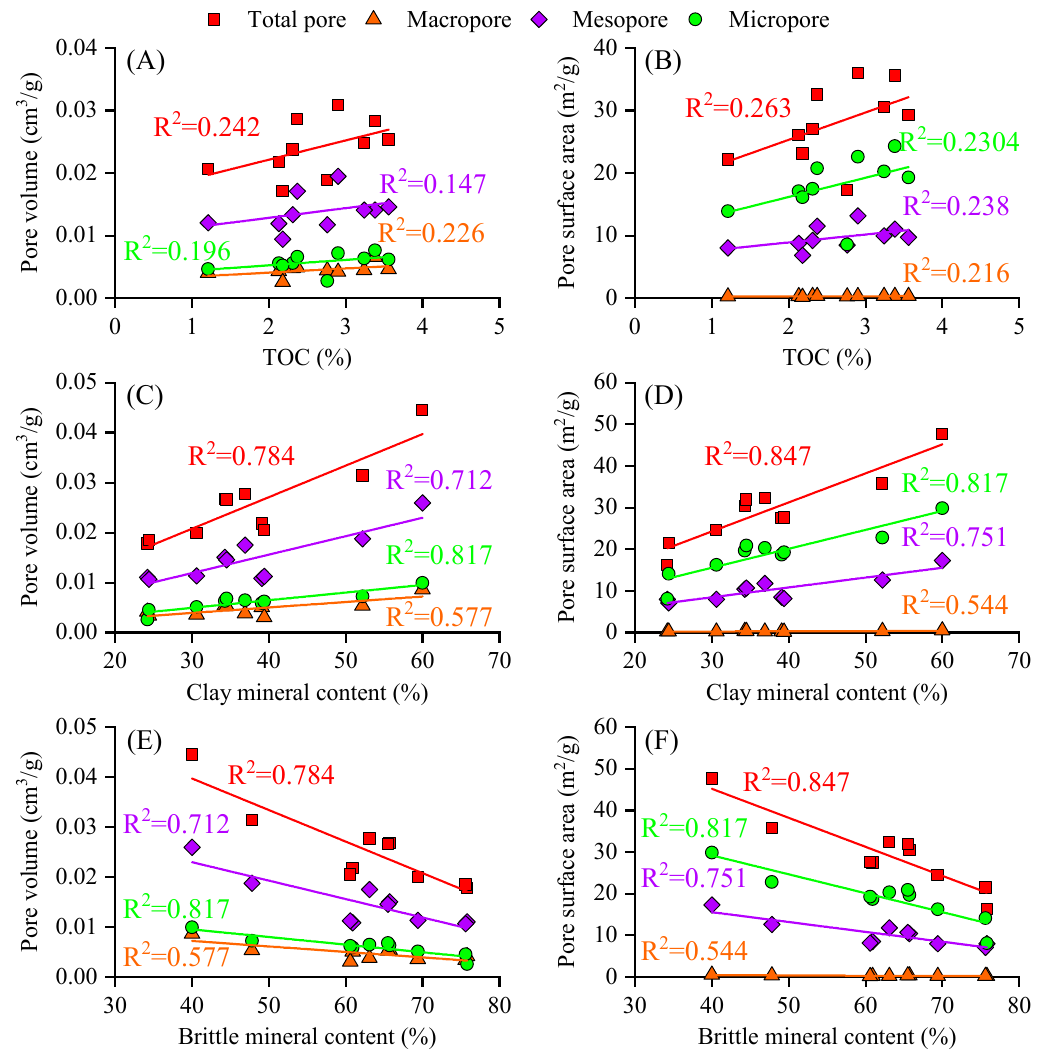
Figure 16. The interrelationship between the pore structure parameters of multi ‐ scales pores and TOC, clay mineral content, and brittle mineral content. (A) PV of different scales versus TOC content; (B) SSA of different scales versus TOC content; (C) PV of different scales versus clay mineral content; (D) SSA of different scales versus clay mineral content; (E) PV of different scales versus brittle mineral content; (F) SSA of different scales versus brittle mineral content.